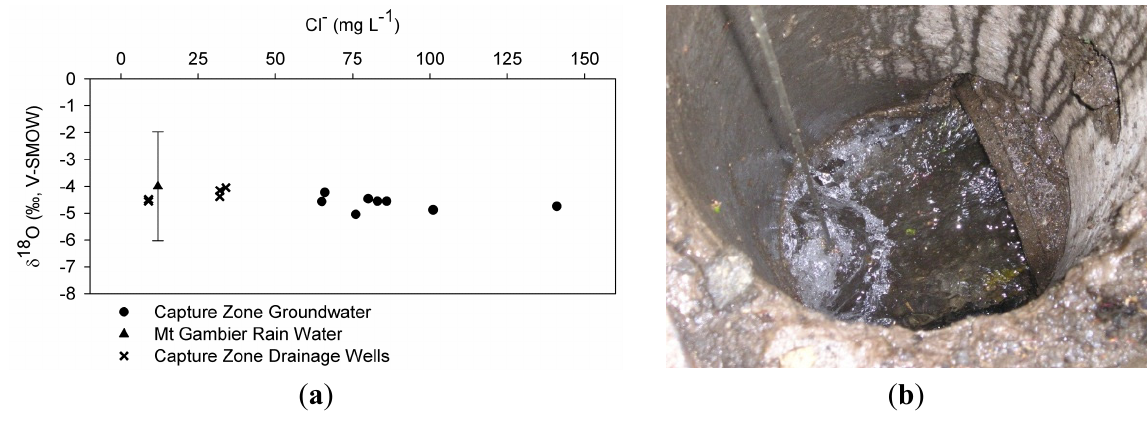
Figure 9. Characteristics of chloride vs. δ 18 O relation, Mount Gambier Blue Lake capture zone ( a ) Chloride vs. δ 18 O relation [1]; ( b ) Direct recharge through a drainage